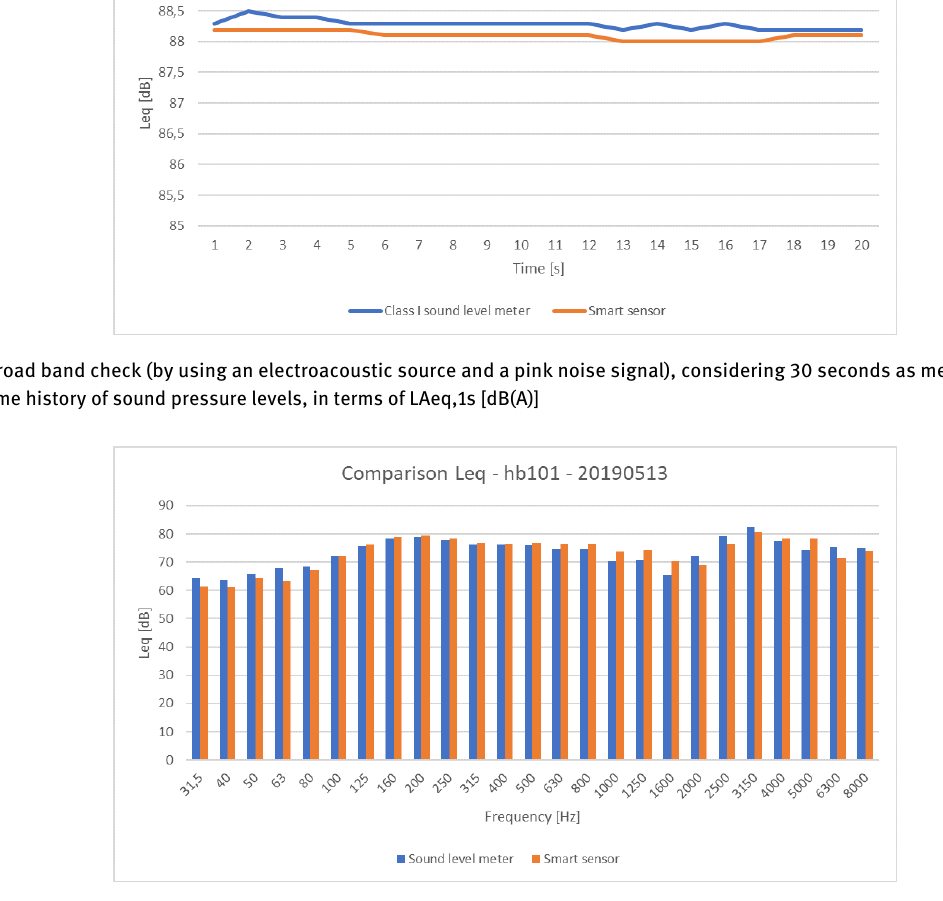
Figure 7: Broad band check (by using an electroacoustic source and a pink noise signal), considering 30 seconds as measurement time period – One third octave band sound pressure levels, in terms of Leq,30s